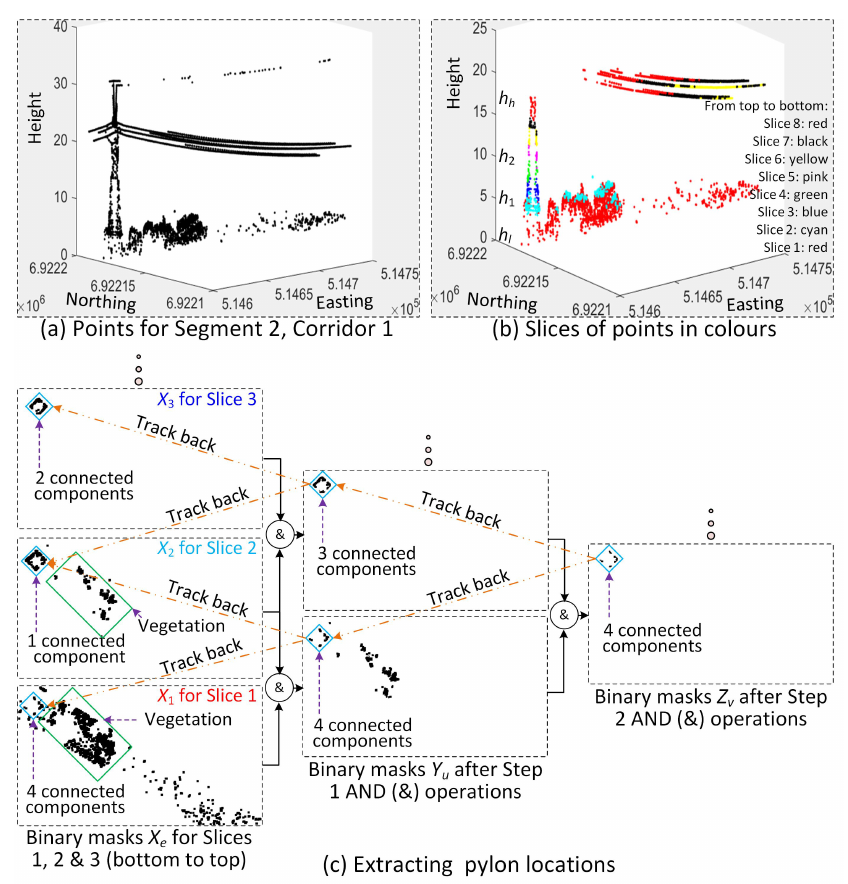
Figure 7. Extraction of pylon locations. Easting, Northing and Height are in metres (m). Within the binary images in ( c ), black pixels indicate “true” and white pixels indicate “false” for any non-ground objects (i.e., pylon, tree,